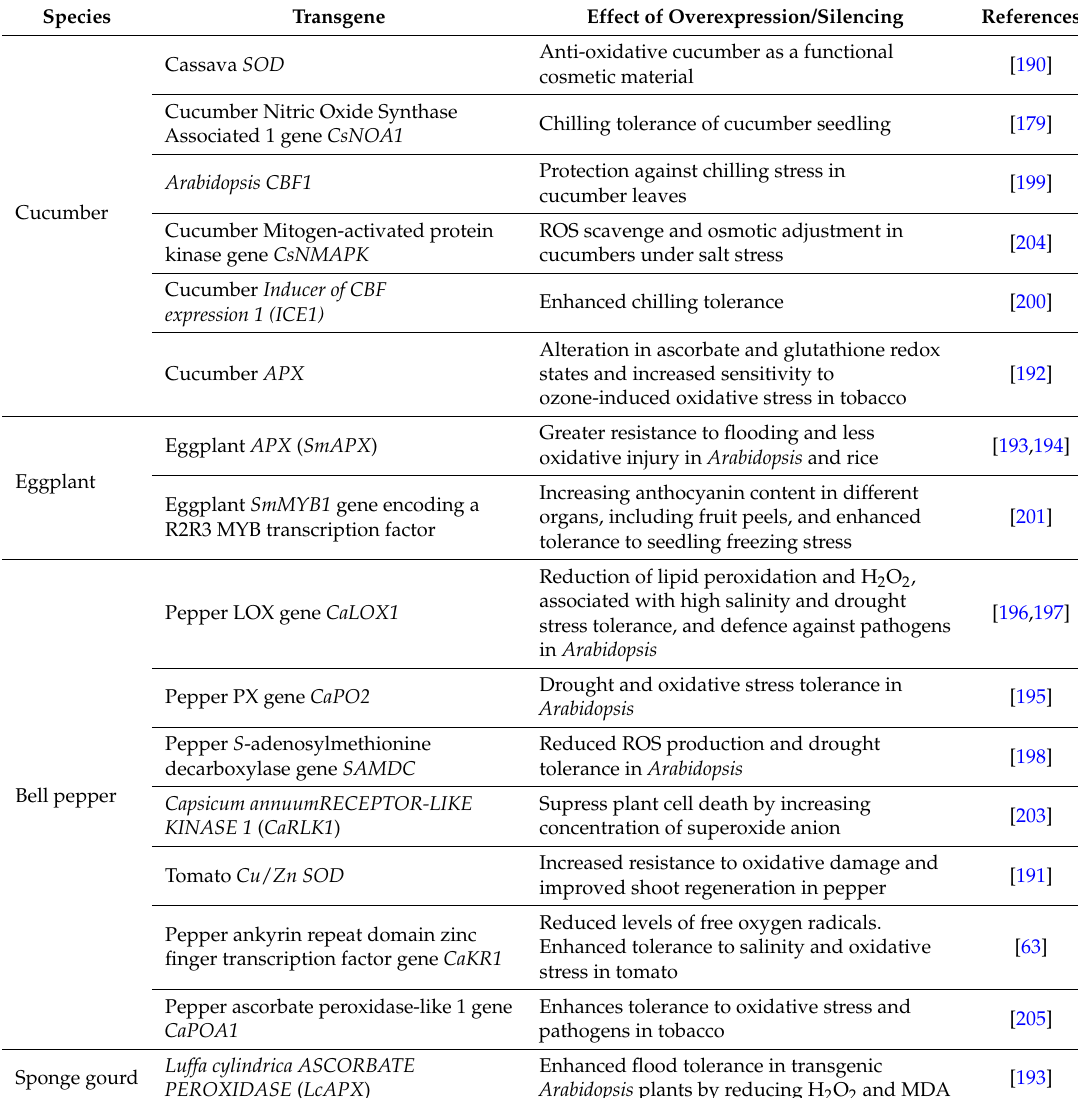
Table 3. Transgenic plants of immature fruit species with enhanced tolerance to oxidative